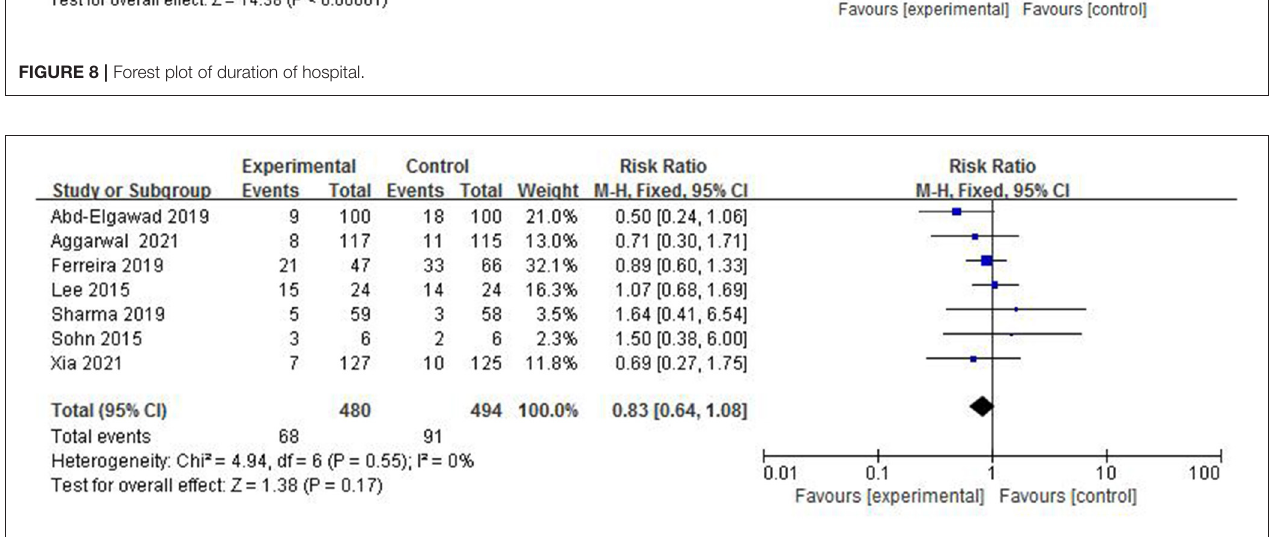
FIGURE 9 | Forest plot of the incidence of BPD.